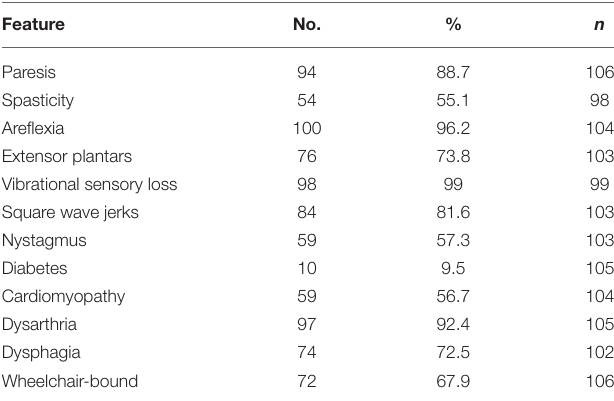
TABLE 3 | Clinical Features in FRDA Patients, group